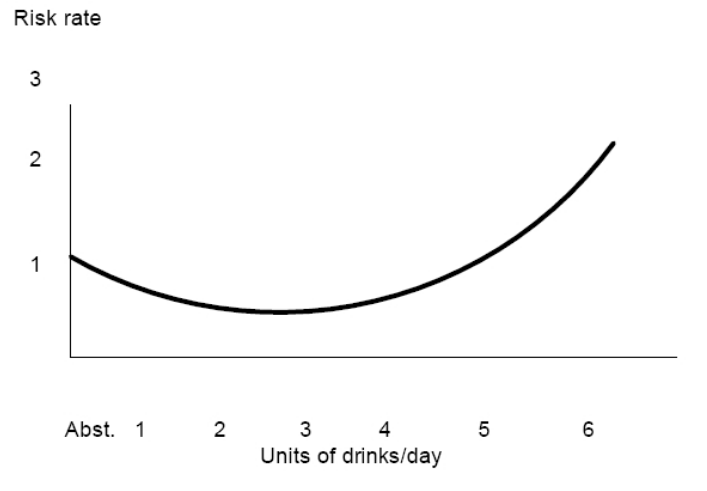
Fig. 1 Correlation between the risk of cardiovascular mortality and the per capita alcohol consumption (after